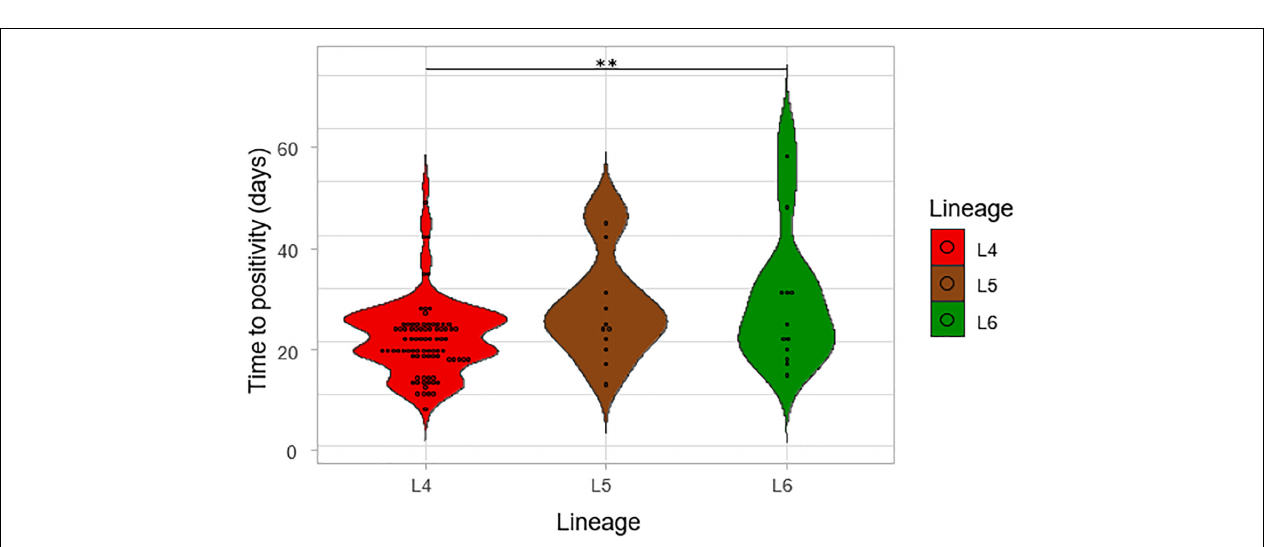
FIGURE 5 | Comparison of the mean Cq values of the lineages using Gene Xpert. The mean of the Cq values of the five probes from the GeneXpert machine was calculated and plotted against the three lineages.